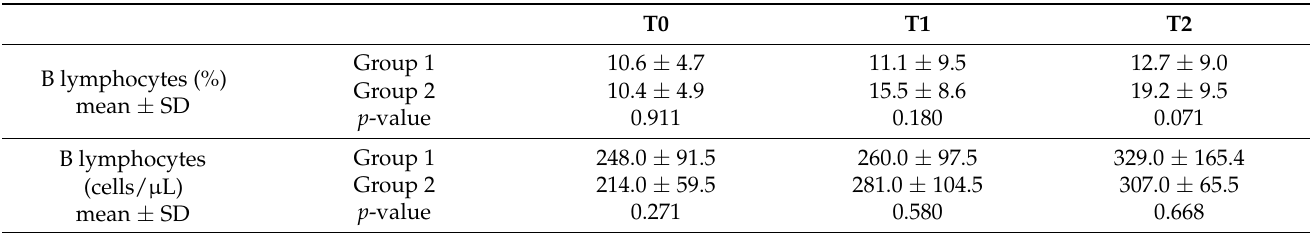
Figure 3. Two factor violin plots for S-IgA. Data, obtained by ELISA immunoassay, are shown as mean ± SE (standard error) at T0 (basal visit) and T2 (after eight weeks of supplementation and four weeks post-immunization) for both groups of patients. Dots represent the individual data and means are connected by lines. p -value derived from planned contrast on t -statistic. Table 3. Absolute and % values of B lymphocyte in HIV+ patients at T0 (basal levels), T1 (after 4 weeks of supplementation), and T2 (after 8 weeks of supplementation and 4 weeks post-immunization). Data were reported as mean ± SD. p -values derived from the contrasts’ analyses are shown in